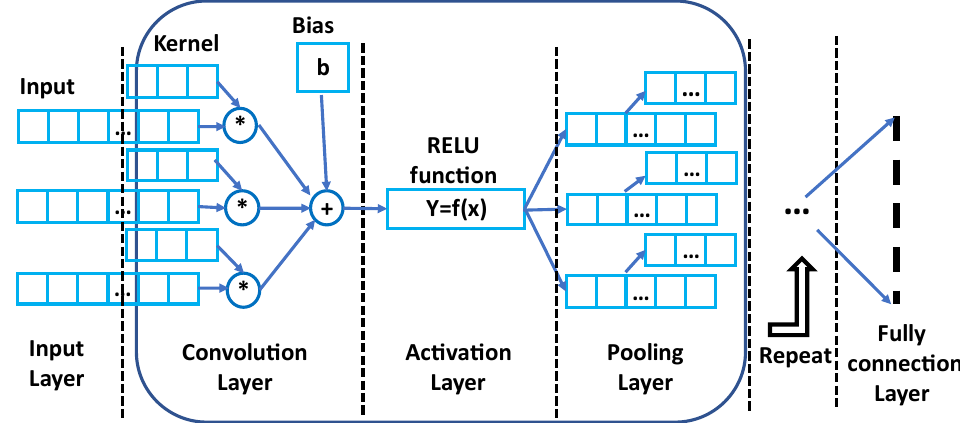
Figure 15. Structure of 1-D CNN